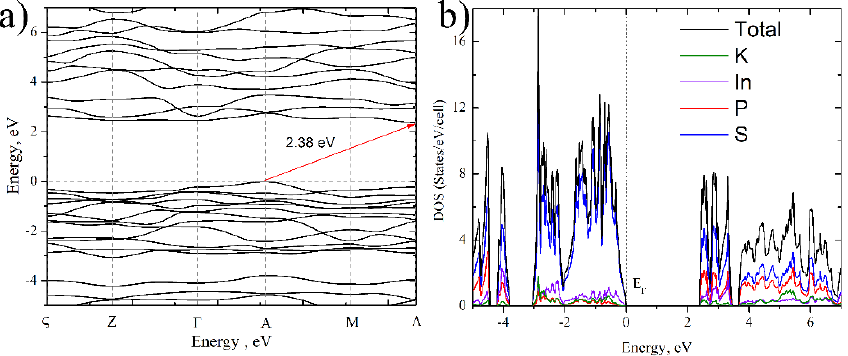
Figure 5. ( a ) Calculated band structure and ( b ) DOS of KInP 2 S 7 .